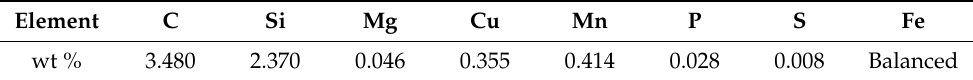
Table 1. Chemical composition of the cast material.